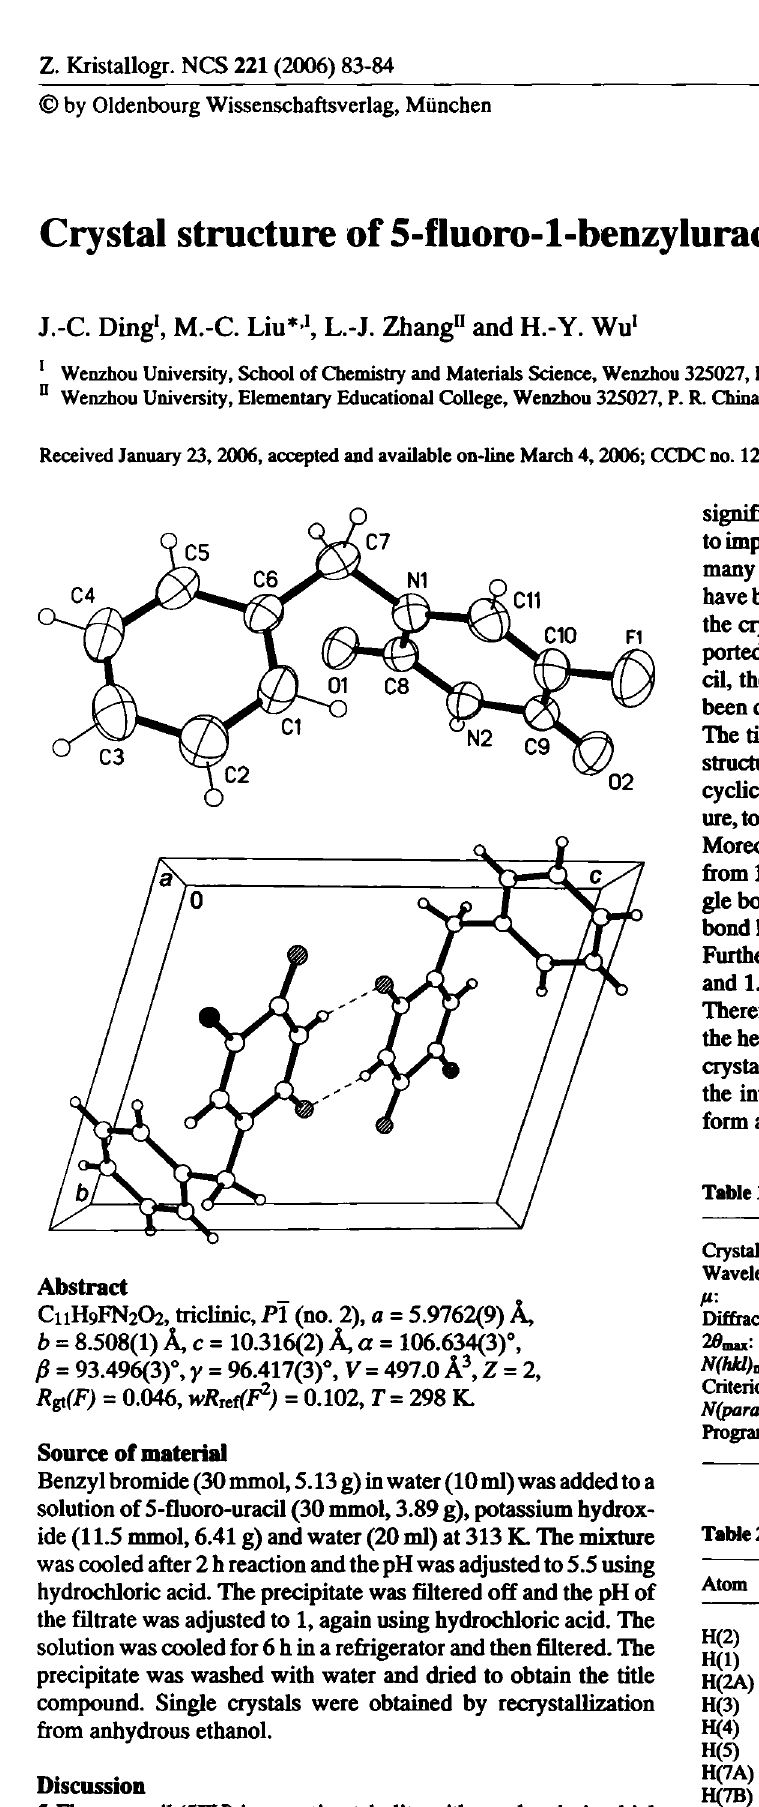
Table 2. Atomic coordinates and displacement parameters (in Ä 2